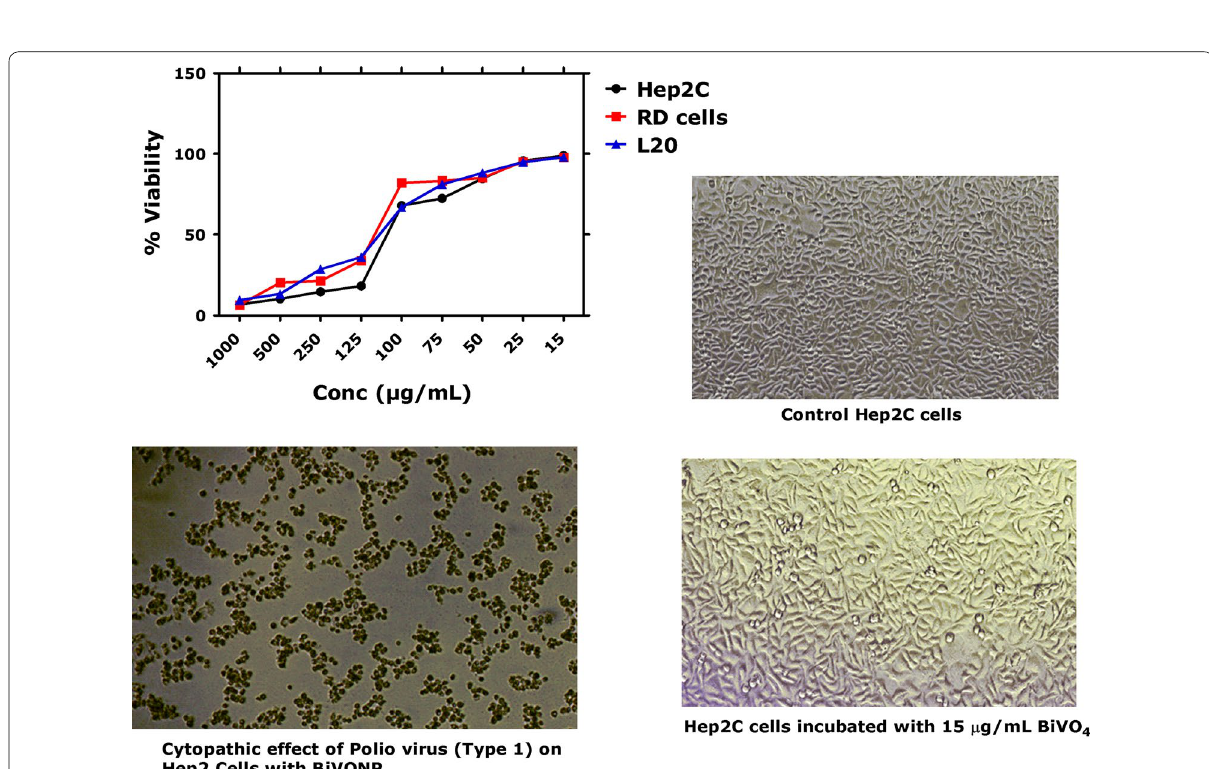
Fig. 8 Cytotoxicity of BiVO 4 nanorods on different cells and investigating their anti-polio virus